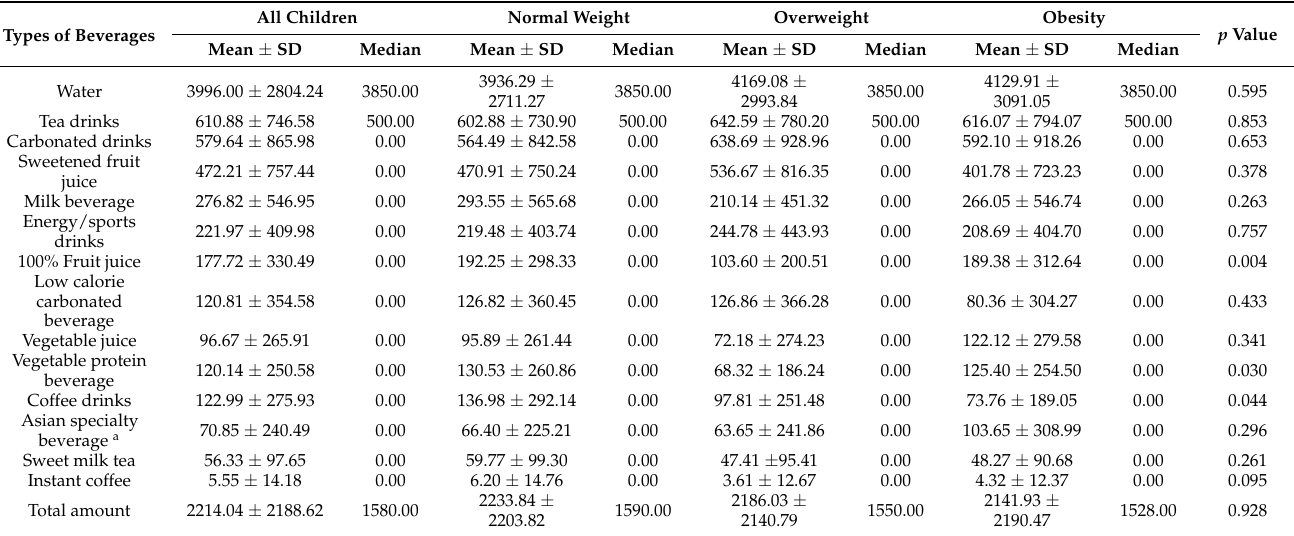
Table 4 reveals that children’s weekly pocket money (OR = 1.696, 95% CI: 1.209–2.380, p < 0.01), frequency of purchase SSBs (OR = 1.770, 95% CI: 1.044–3.001, p < 0.05),